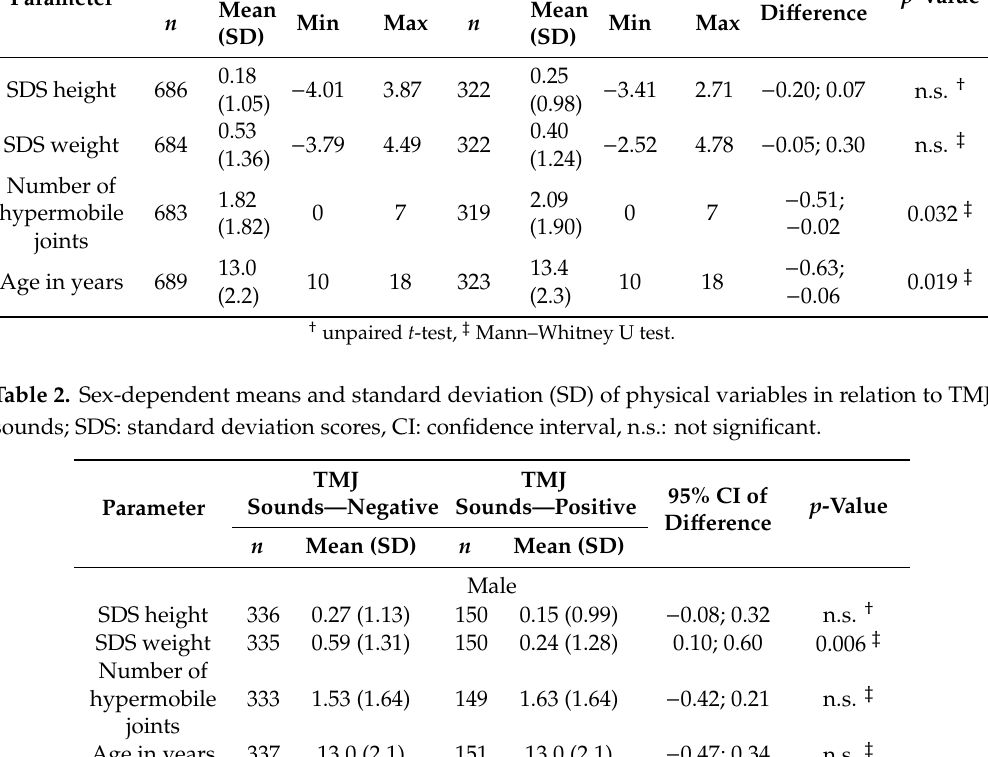
Table 1. Means and standard deviation (SD) of physical variables in relation to temporomandibular joint (TMJ) sounds (both sexes); SDS: standard deviation scores, CI: confidence interval, n.s.: not significant. TMJ Sound—Negative Parameter